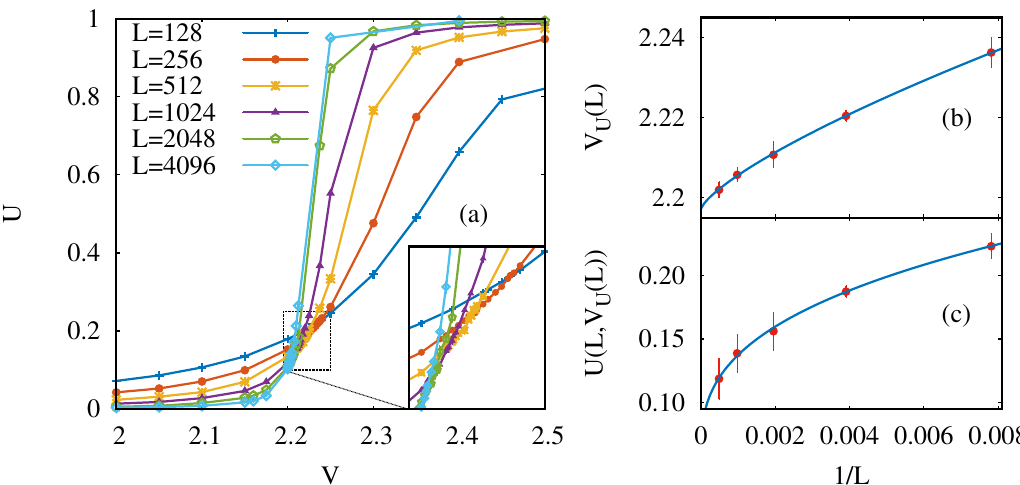
Figure 2: Binder cumulant scaling in the ground state regime (in all panels, α = 1.50). Panel (a): Binder cumulant curves as a function of V for different system sizes. Solid lines are a guide to the eye. Inset: magnification of the curve crossing ( L ) between the Binder cumulant region. Panel (b): computed crossing positions V U curves at system sizes L and 2 L . The continuous line is a numerical fit to the ex- pected FSS behavior in eq. (4). Panel (c): computed values of the Binder cumulant ( L ) between system sizes L and 2 L . The continuous line is at the crossing points V U a numerical fit to the predicted FSS behavior in eq.